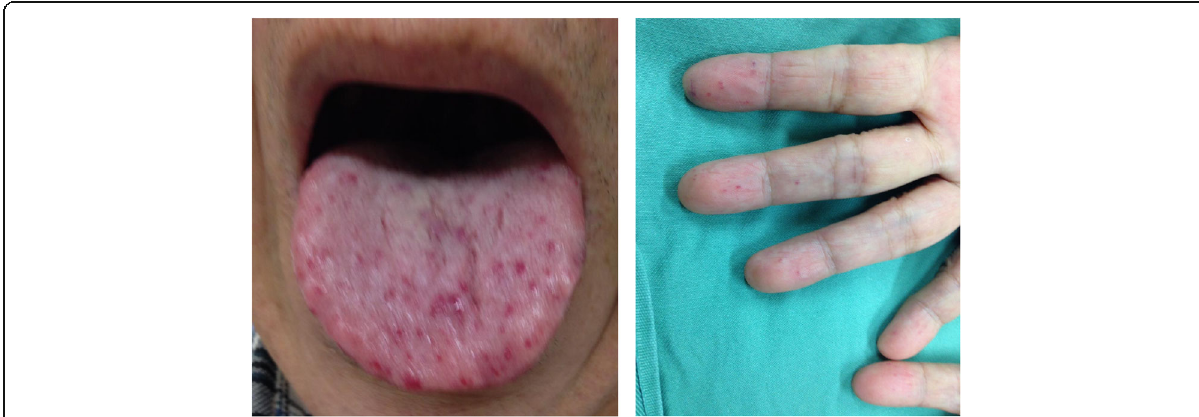
Fig. 4 Physical findings. The patient had telangiectasias on his tongue and